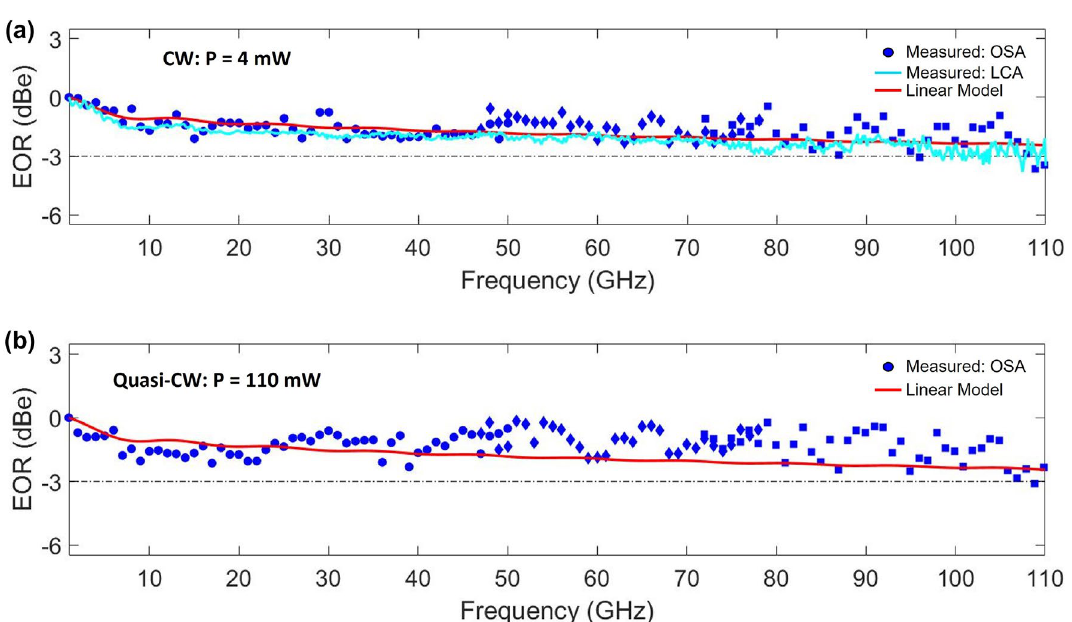
Figure 5. The OSA-measured (blue points) EOR of the hybrid bonded Si/LN MZM with L ps = 0.5 cm using no RF multiplier (circles), a 4x multiplier (diamonds), and a 6x multiplier (squares) resulting in a measured 3-dB bandwidth of 110 GHz for both: ( a ) Low power, CW optical input with 4 mW of power; and ( b ) Quasi-CW optical input with peak power of 110 mW. The solid red line is the calculated linear model using Eq. (4a) with no nonlinearities. The cyan line in panel ( a ) is the EOR of an identically designed Si/LN MZM using a high speed